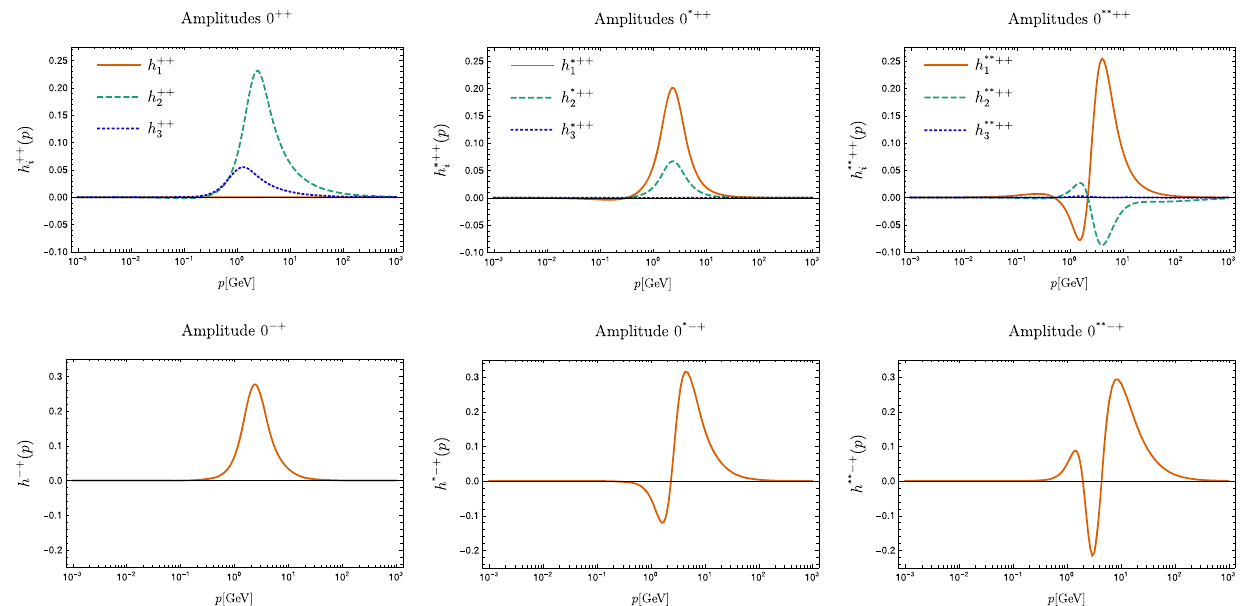
Fig. 8 Leading amplitudes for the scalar (top) and pseudoscalar (bottom) ground states (left), first excited states (middle) and second excited states (right) for the lowest calculated P 2 >